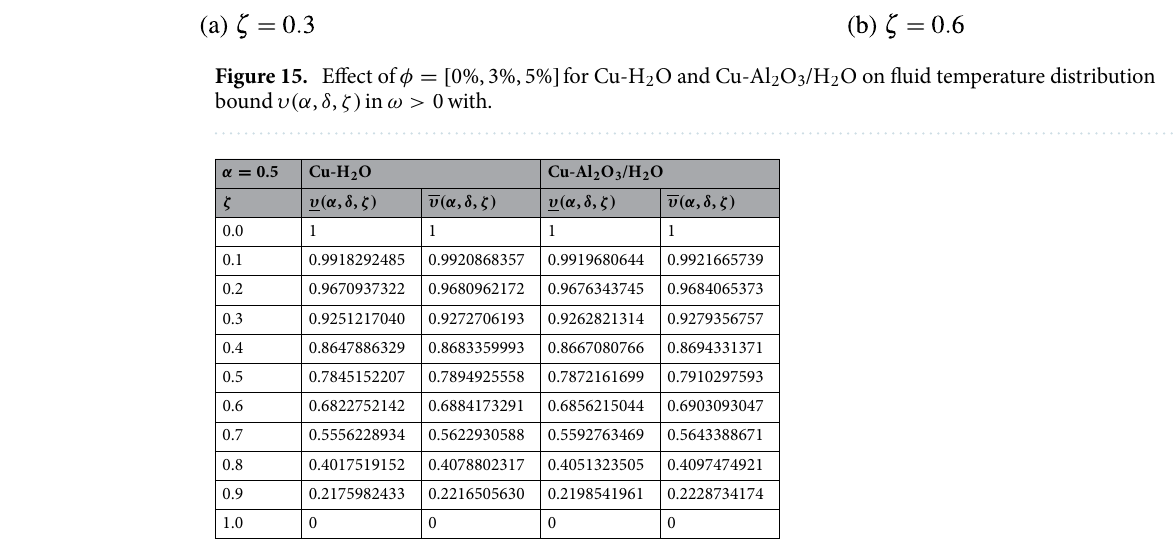
Table 7. Fuzzy velocity distribution of lower and upper bound in converging channel when various values of ζ and α = 0.5, Ha = 500, Re = 15, ω = − 3 0